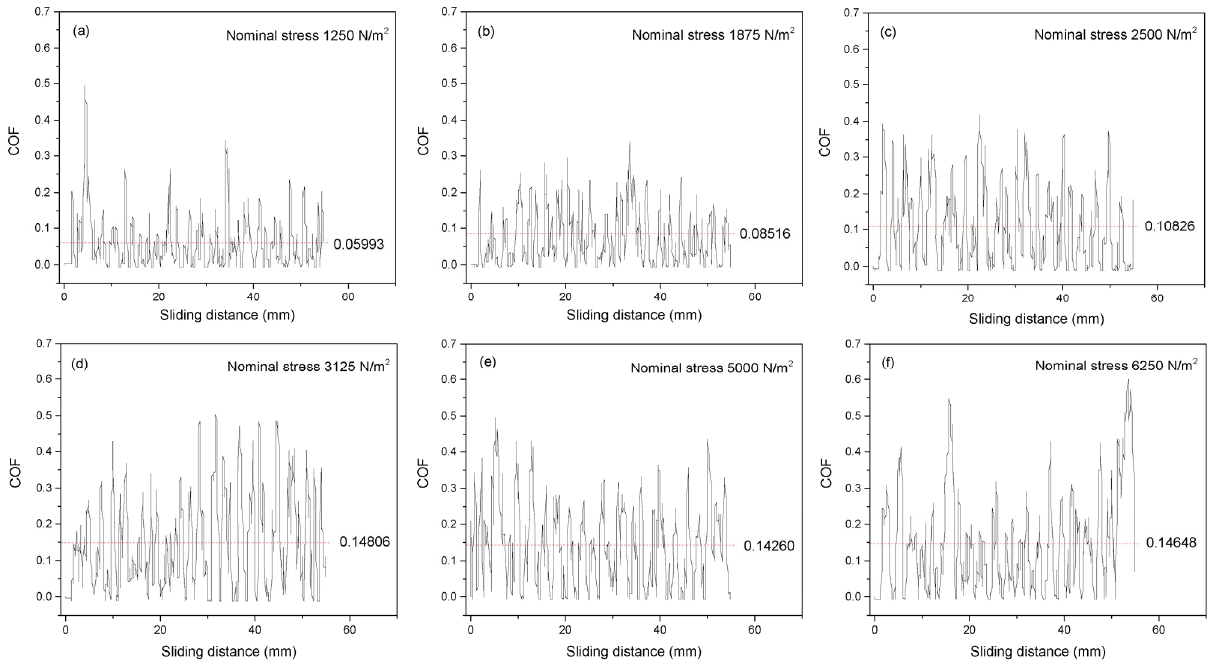
Fig. 7 Variation of COF with sliding distance of 55 mm under different nominal stress when the area ratio was 43.29%. (a) 1,250 N/m 2 ,